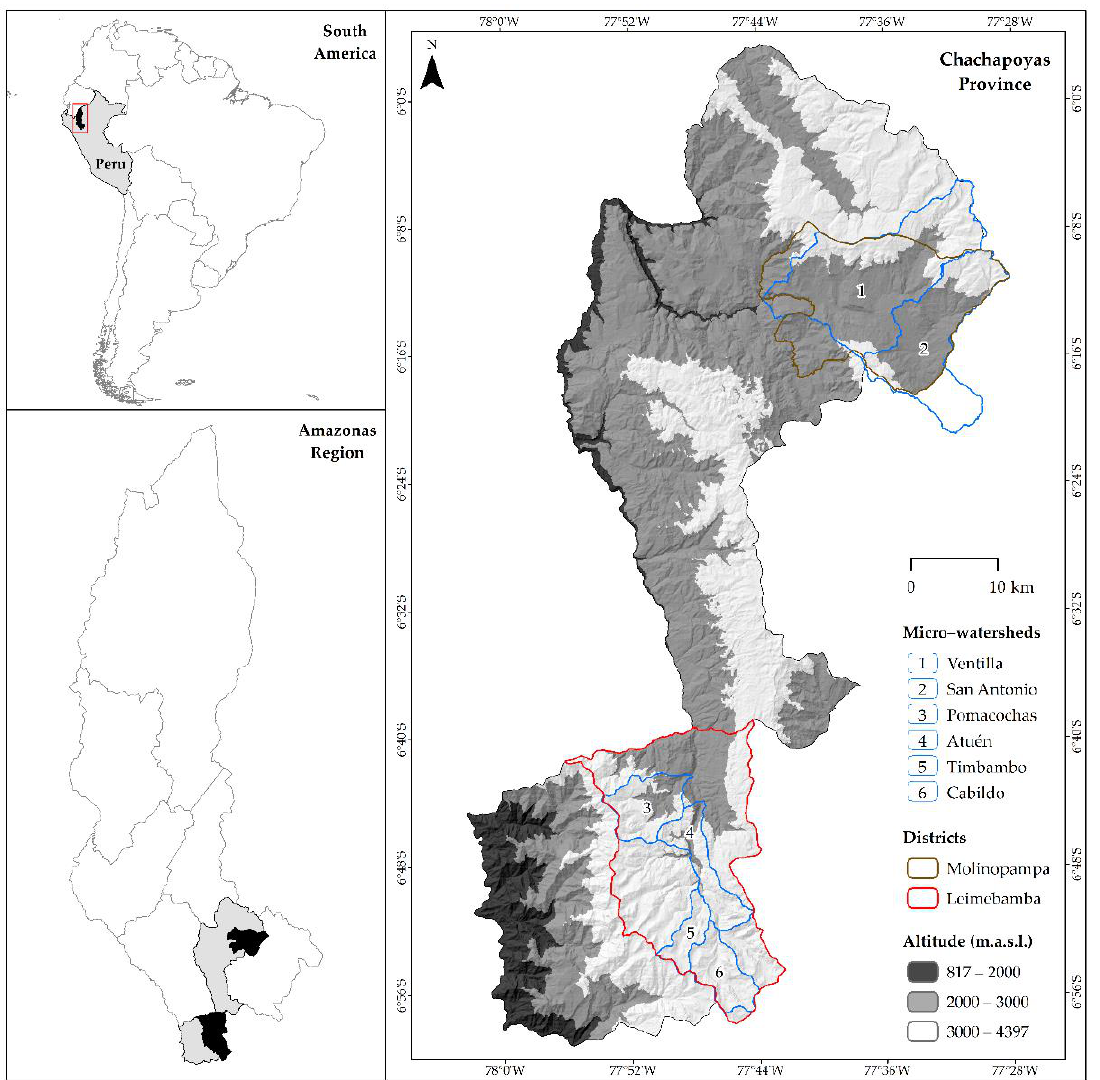
Figure 1. Location of High Andean livestock micro-watershed (HAL-MWs) in Leimebamba and Molinopampa, Chachapoyas–Amazonas, in northern Peru.